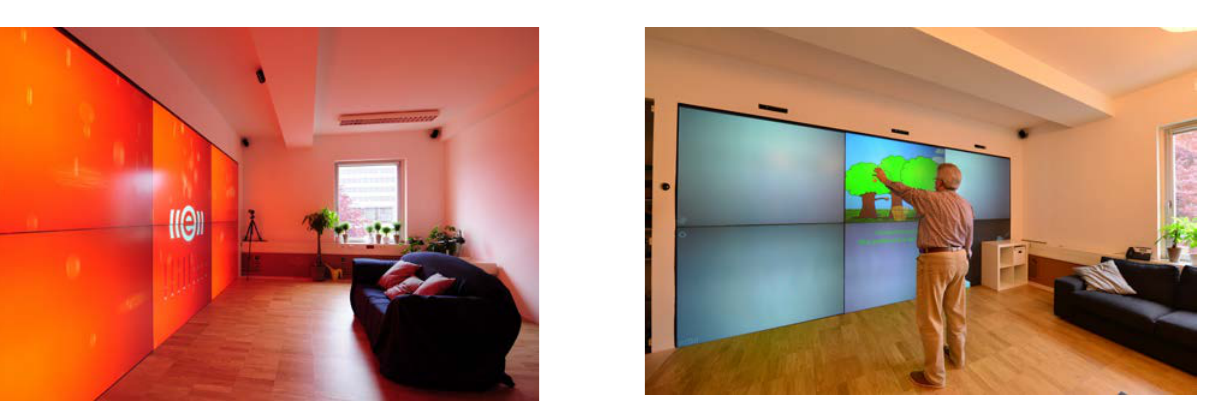
Figure 1. Ambient assisted living